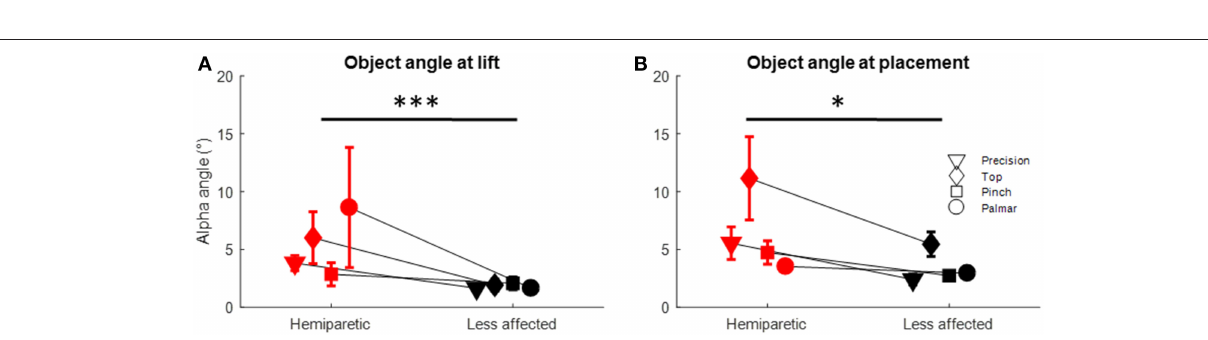
Frontiers in Neurology |